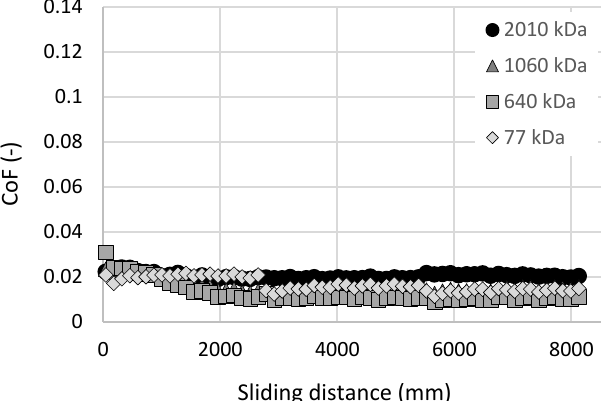
Figure 6. Coefficient of friction as a function of sliding distance for polyvinyl alcohol (PVA) hydrogel-on-glass configuration and HA solutions with different molecular weights.